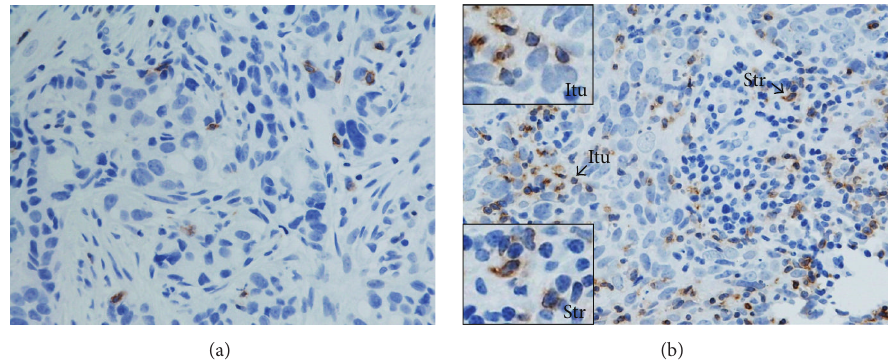
Figure 4: PD-1 + T cells in the sections of LLABCs, using IHC staining, at 400x magnification. Briefly, heat-mediated antigen retrieval was performed using citrate buffer, pH 6 (20mins). The sections were then incubated with MAbs to PD-1 (Abcam, ab52587) at a 1:100 dilution for 30 mins at RT. Polymeric HRP-linker antibody conjugate was used as secondary antibody. DAB chromogen was used to visualize the staining. The sections were counterstained with haematoxylin. (a) Low level of PD-1 + T cell infiltration; (b) high level of PD-1 + T cell infiltration. The average number of brown membrane-stained cells, regardless of intensity, in contact with tumour cells or within tumour cell nests (Itu: intratumoural) and in the interstitial stroma (Str: stromal) per HPF was